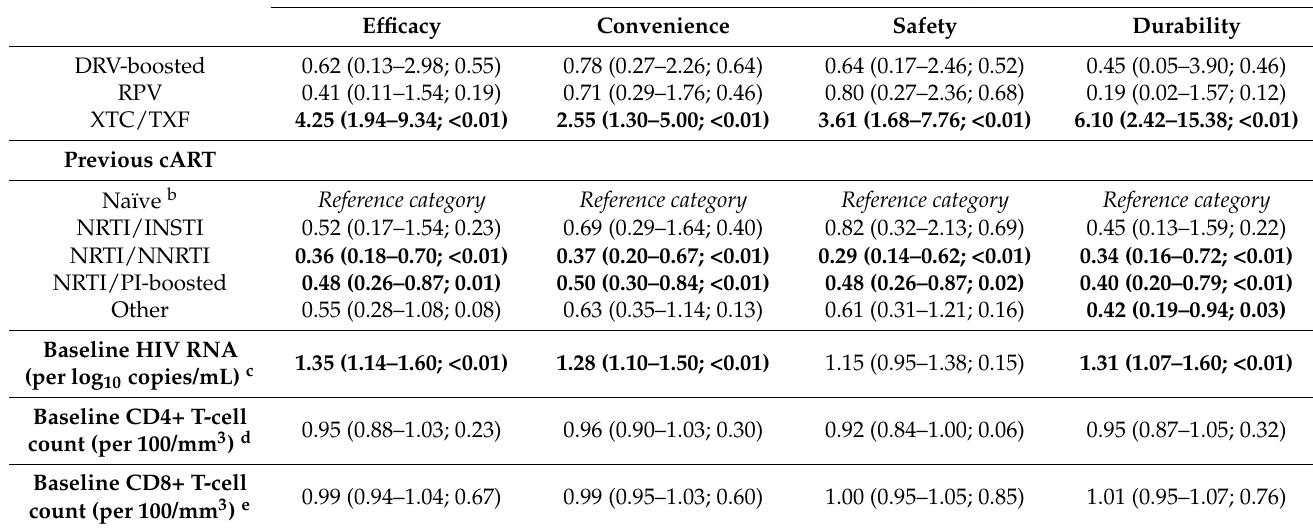
Figure 5. Kaplan–Meier survival curve, obtained by a competing risk analysis, shows how the tenofovir-containing backbone was mainly interrupted due to simplification strategies. DURAB, du- rability; SEMPL, simplification; ART, antiretroviral treatment; TOXIC, toxicity; RPV, rilpivirine; TXF, tenofovir alafenamide or tenofovir disoproxil fumarate; XTC, emtricitabine or lamivudine; 3TC, lamivudine; ABC, abacavir; DRV, darunavir; Boost, ritonavir-boosted regimens. X -axis: time (days); Y -axis: survival rate (%).